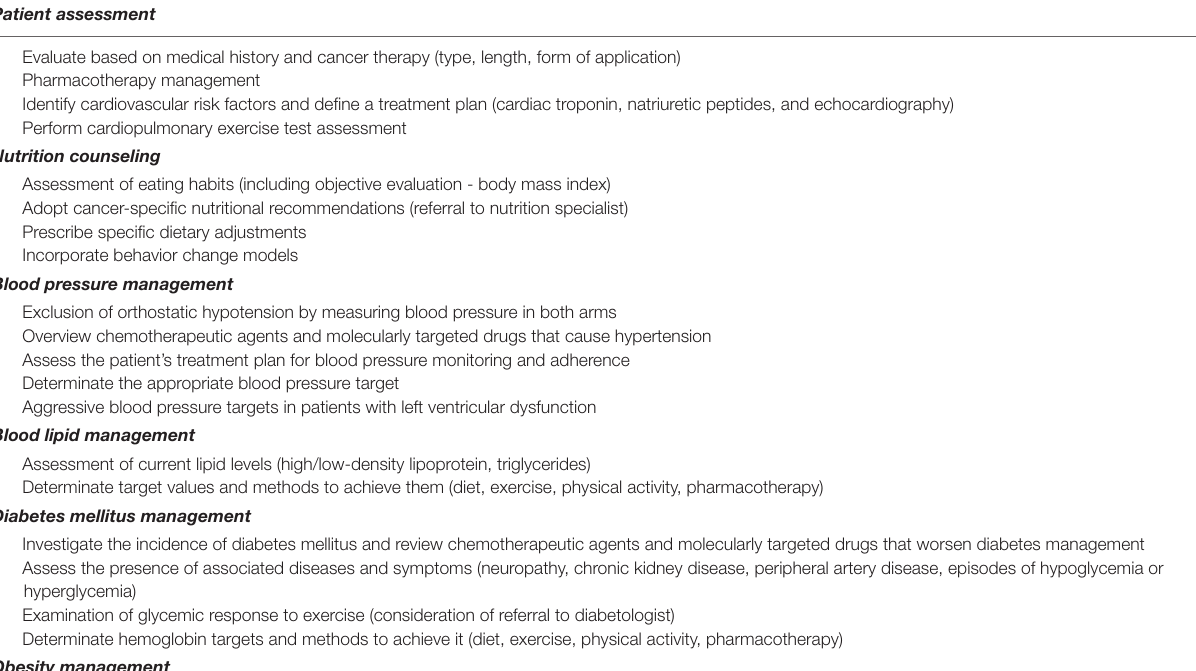
TABLE 1 | Key preventive components of CORE (10,